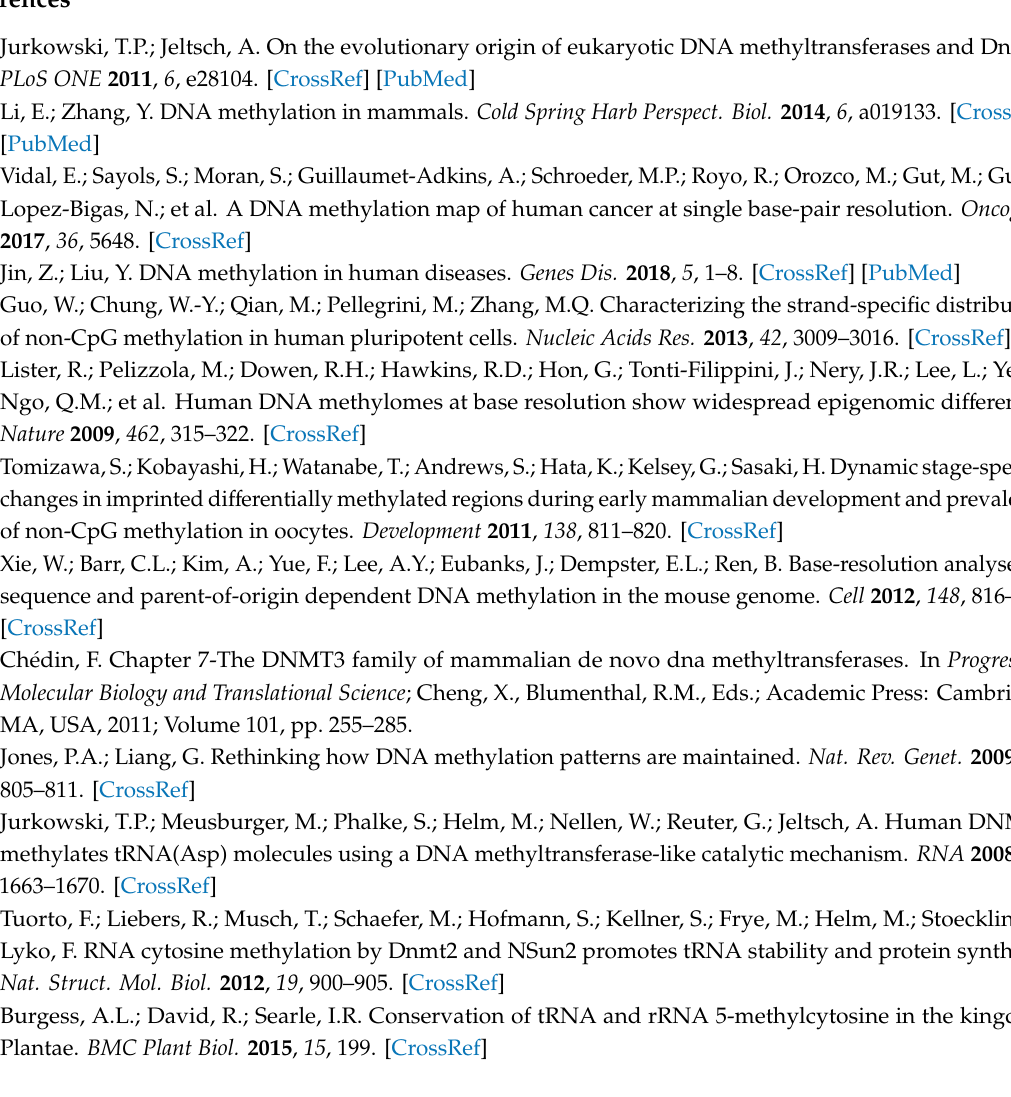
Table S1: Overview of all primers used in this work, Table S2: Overview of bisulfite converted and sequenced samples in this study with SRA accession numbers, Table S3: Sequencing statistics (raw reads, mapped reads and coverage per sample) for all bisulfite sequenced samples, Table S4: Methylation call statistics per bisulfite sequenced sample. TableRaw sequencing data is available in the Sequence Read Archive under project accession numbers PRJNA560731 and